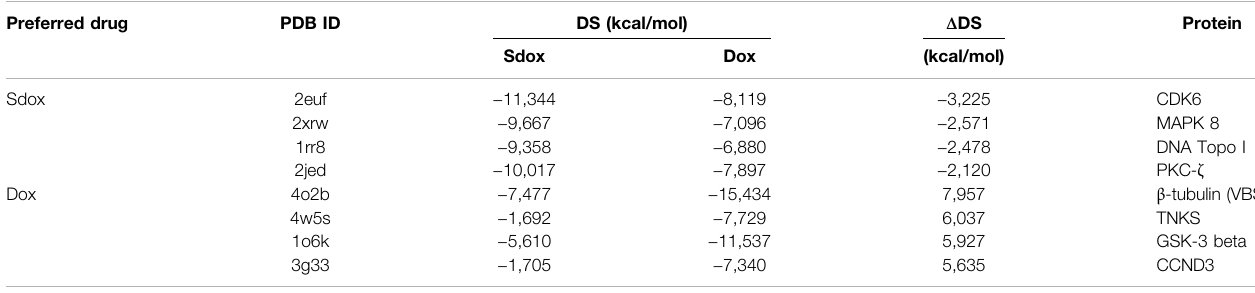
TABLE 6 | Top-ranked Δ DS values obtained for Sdox and Dox. Preferred drug